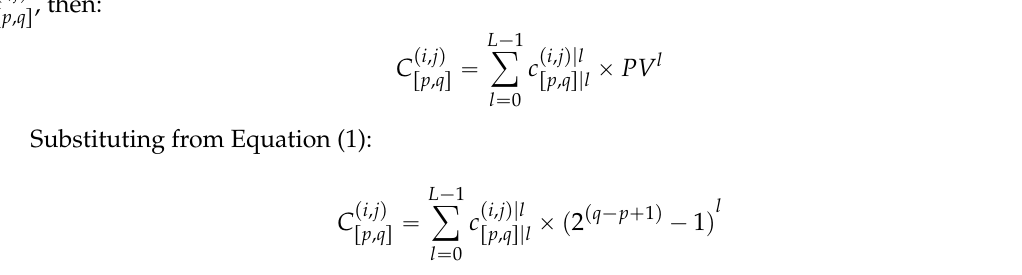
Figure 4. Bit numbering method of a pixel in a layer.